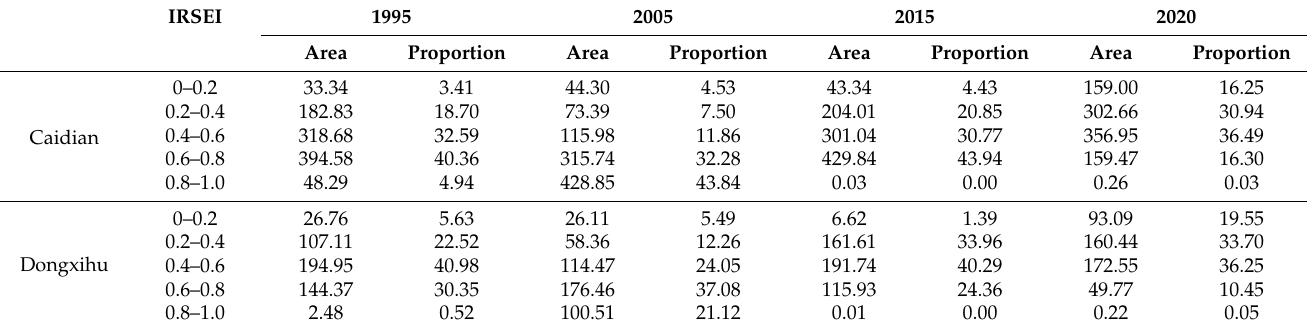
Table 7. Change in the ecological index grade.